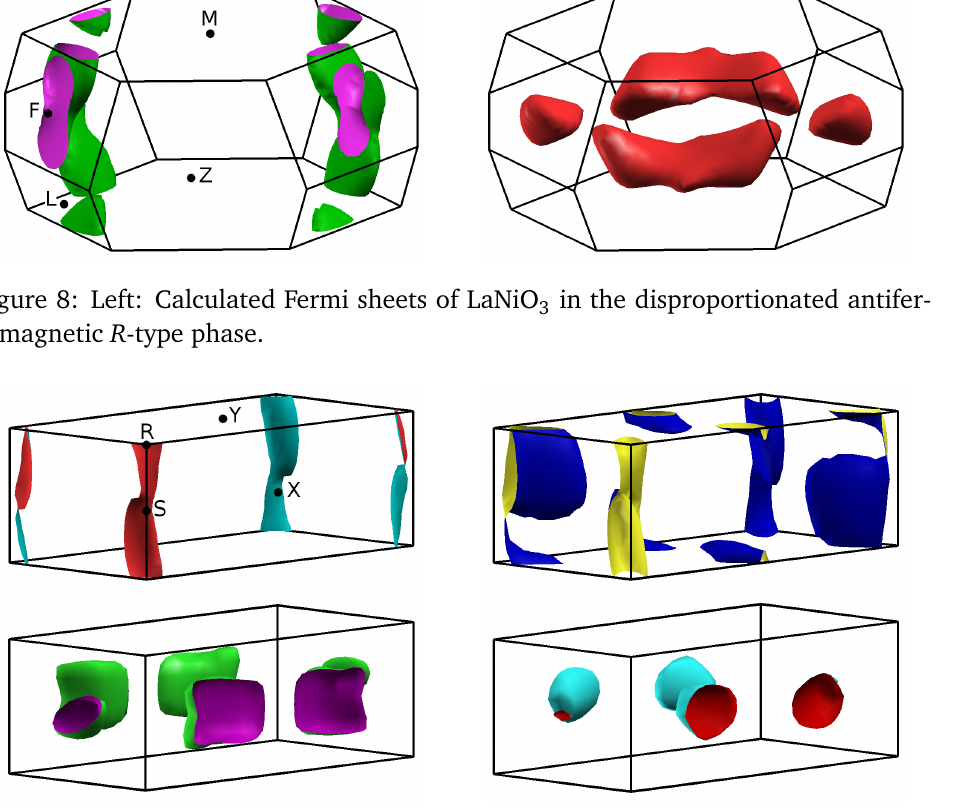
in the disproportionated antifer- 3